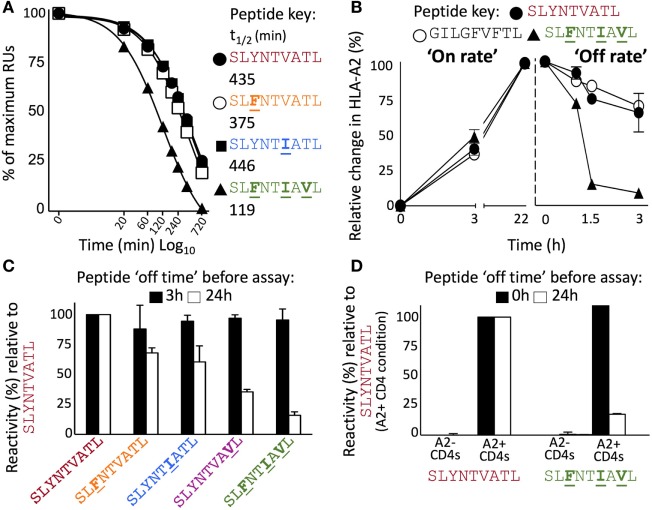
Instability at the cell surface mediates viral escape by the triple mutant epitope, A2–SLFNTIAVL. (A) Relative binding of 868 TCR to A2–peptide complexes by SPR over time. The SPR chip was maintained at 37°C. Functional half-life was determined by injecting the 868 TCR at a fixed concentration of 100 µM over 720 min and recording the drop in total RUs over 8 different time points. A faster drop in RUs (converted into a T1/2) was interpreted to indicate greater peptide instability, detected by loss of binding by the antigen-specific 868 TCR. (B) Left panel shows relative HLA-A2 expression following incubation (0, 3, and 22 h) of T2 cells with indicated peptide. Results are normalised to the maximum mean fluorescence intensity seen for each peptide. The right panel shows T2 cells incubated with peptide for 22 h prior to being washed and cultured in an excess of AIM-V media for the indicated times prior to staining and fixing. Data displayed as HLA-A2 expression relative to maximum seen at 22 h. (C) T2 cells were pulsed for 1 h with the peptides shown, washed extensively, and then cultured in an excess of media for 3 h (black bar) or 24 h (open bar) before being co-incubated for 5 h with T-cells from two donors transduced with the 868 TCR. CD107a and TNFα were used to establish percentage reactivity by flow cytometry. Values were normalised relative to SLYNTVATL peptide. SEM is shown for two different donor T-cells. Untransduced CD8+ T-cells did not respond to peptide (data not shown). Raw data for panel (C) is shown in Figure S1 in Supplementary Material. (D) As panel (C) but using primary HLA-A2− and HLA-A2+ CD4+ T-cells as targets and culturing in excess media for either 0 or 24 h prior to assay. Raw data for panel (D) is shown in Figure S2 in Supplementary Material.